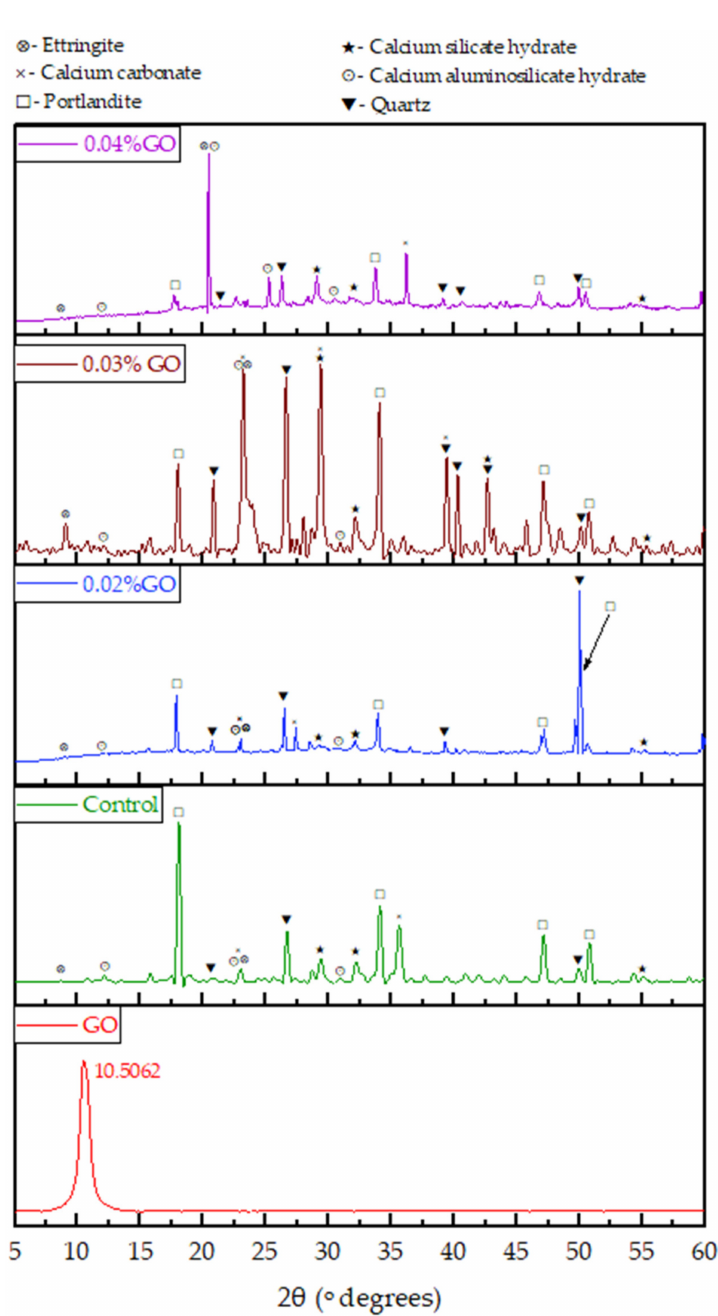
Figure 9. XRD analysis of GO and cement mortar with